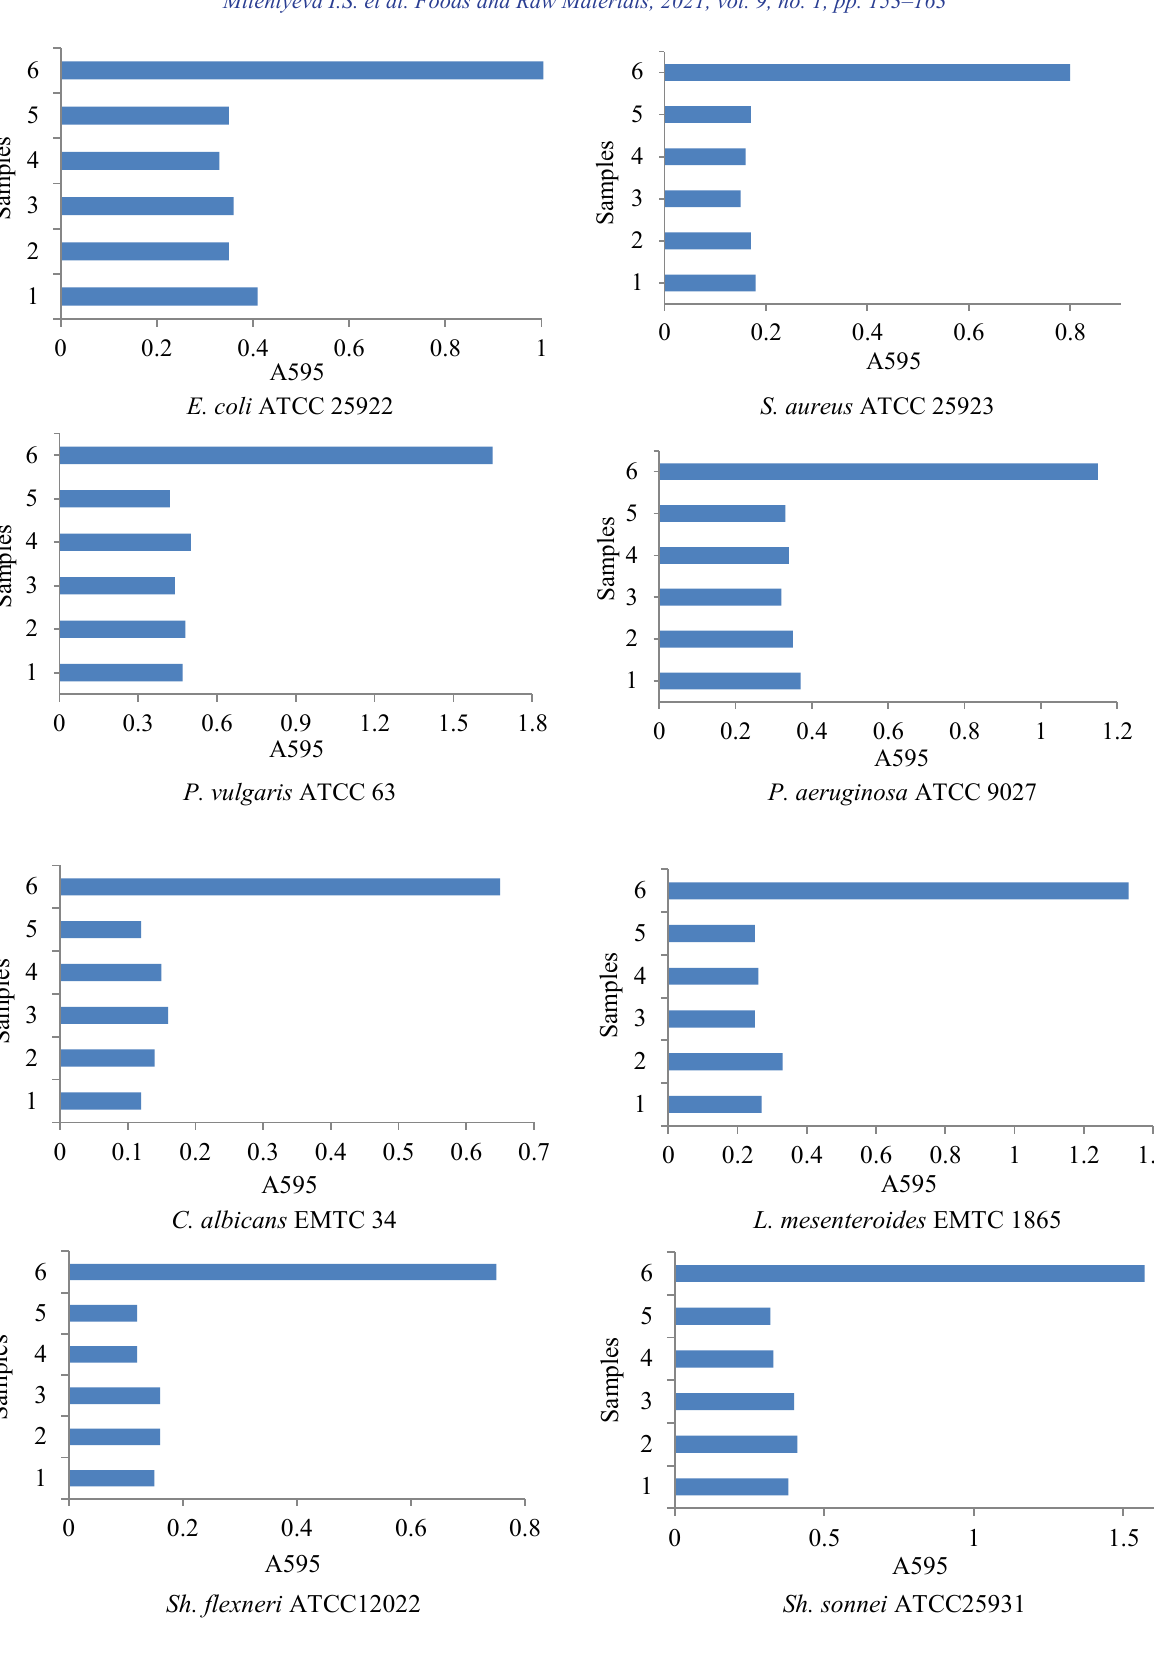
Figure 4 Antimicrobial activity of root extracts (optical density method): 1 – Eleutherococcus senticosus ; 2 – Codonopsis pilosula ; 3 – Platanthera bifolia ; 4 – Saposhnikovia divaricata ; 5 – ciprofloxacin; 6 –